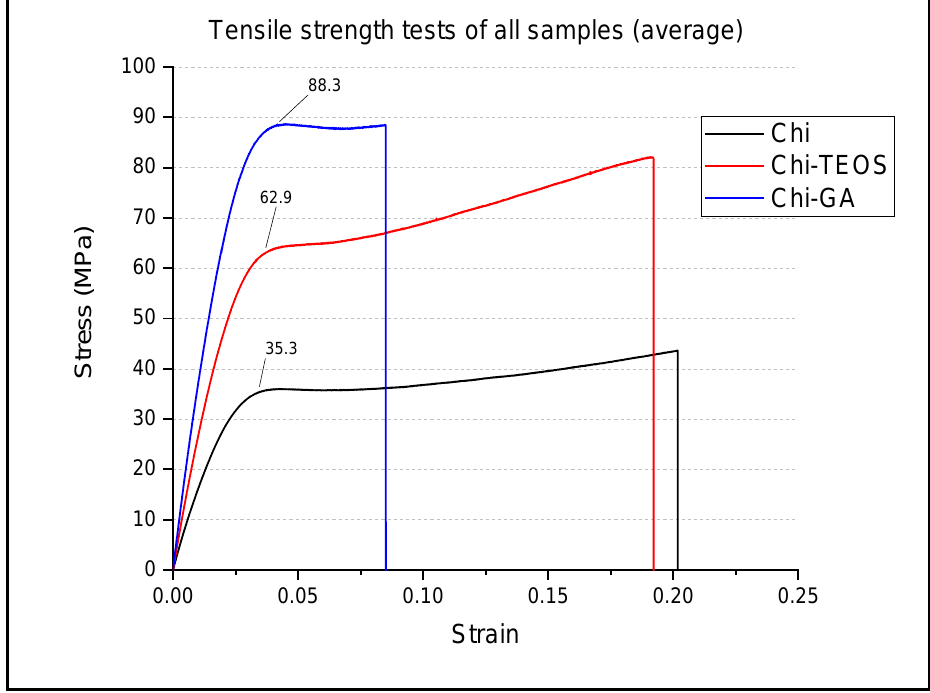
Figure 7. Median values of stress vs. strain for all samples studied.